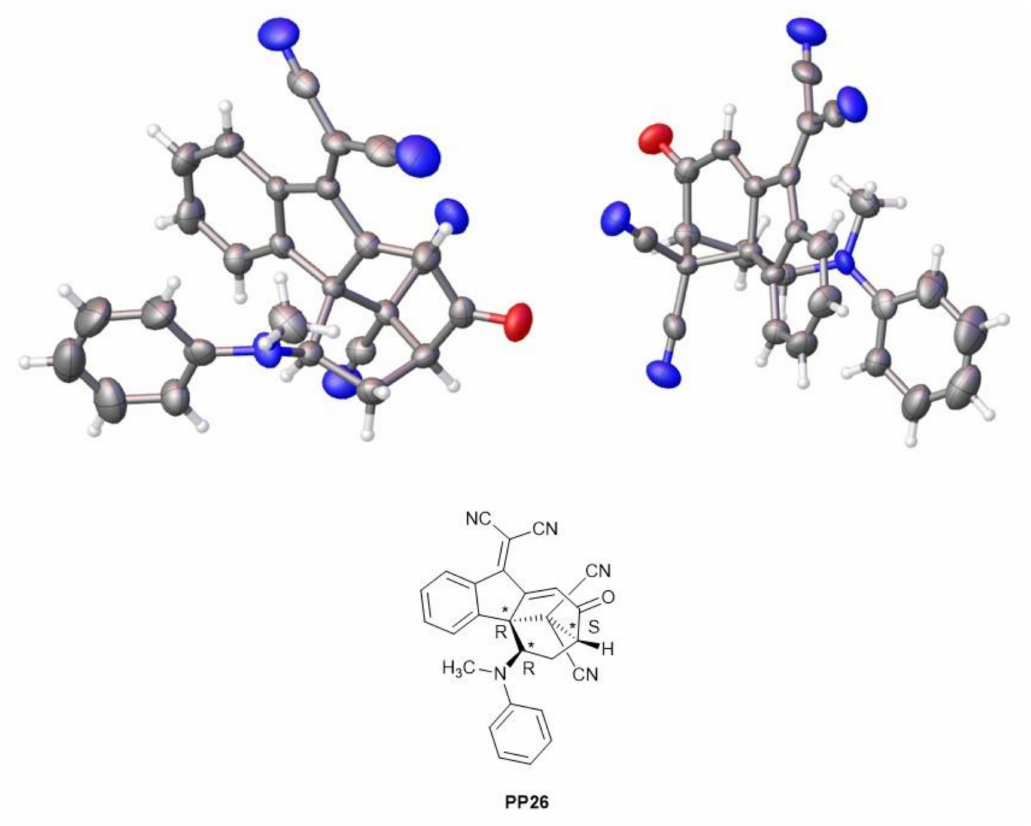
Figure 4. Crystal structure of PP26 .